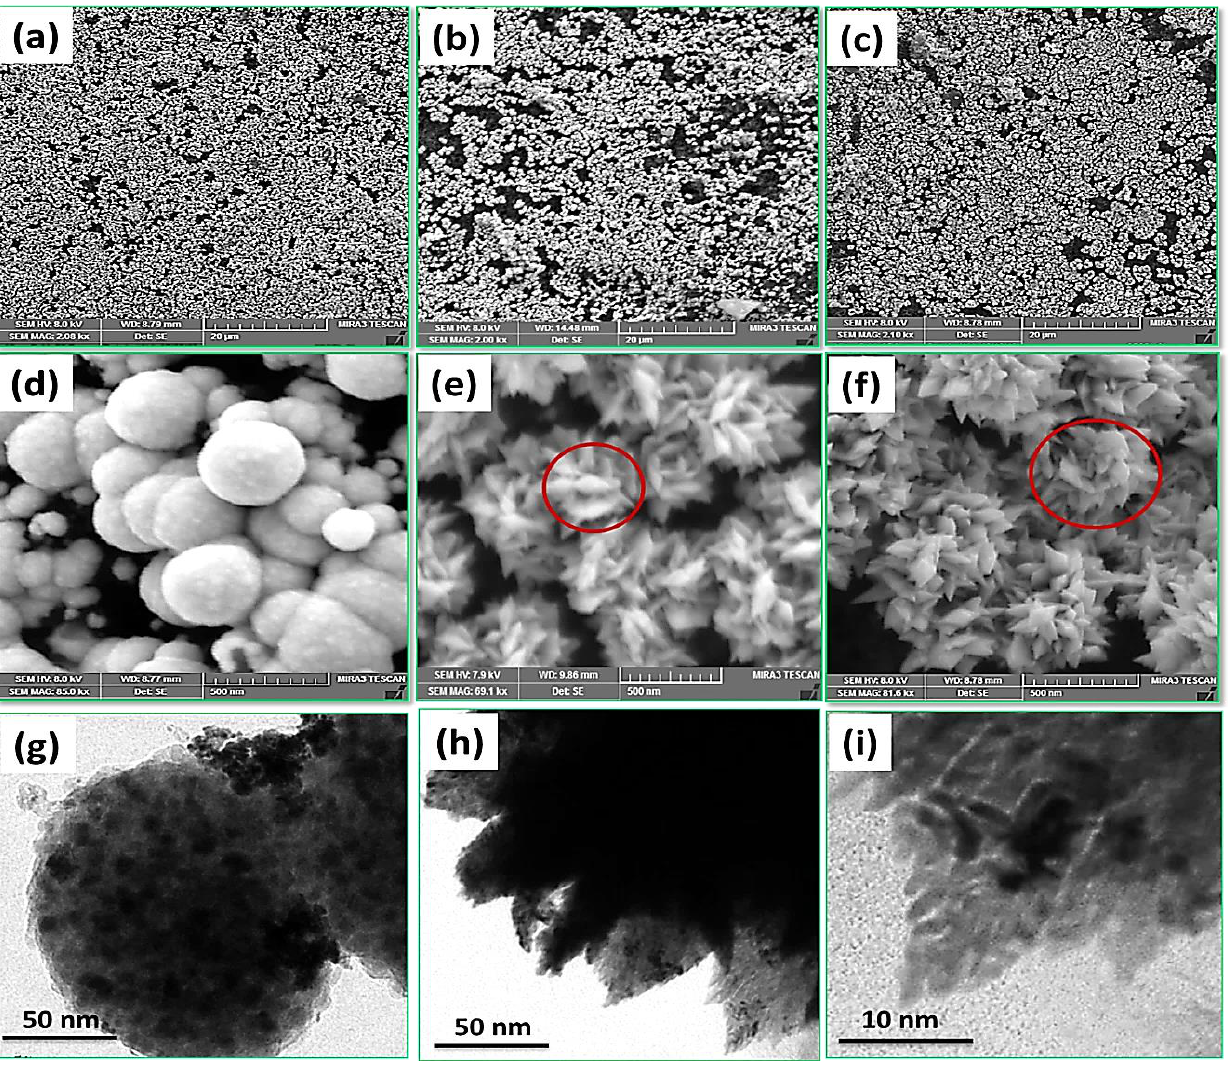
Figure 1. Low-magnification field emission scanning electron microscope (FE-SEM) micrographs ( a – c ) and high magnification ( d – f ) with various Pt deposition current densities of 1.5, 6, and 15 mA cm −2 and ( g – i ) high resolution transmission electron microscopy (HR-TEM) image with Pt deposition current densities of 1.5 and 6 mA cm −2 . ( e , f —circled region shows dentritic flower-like morphology)